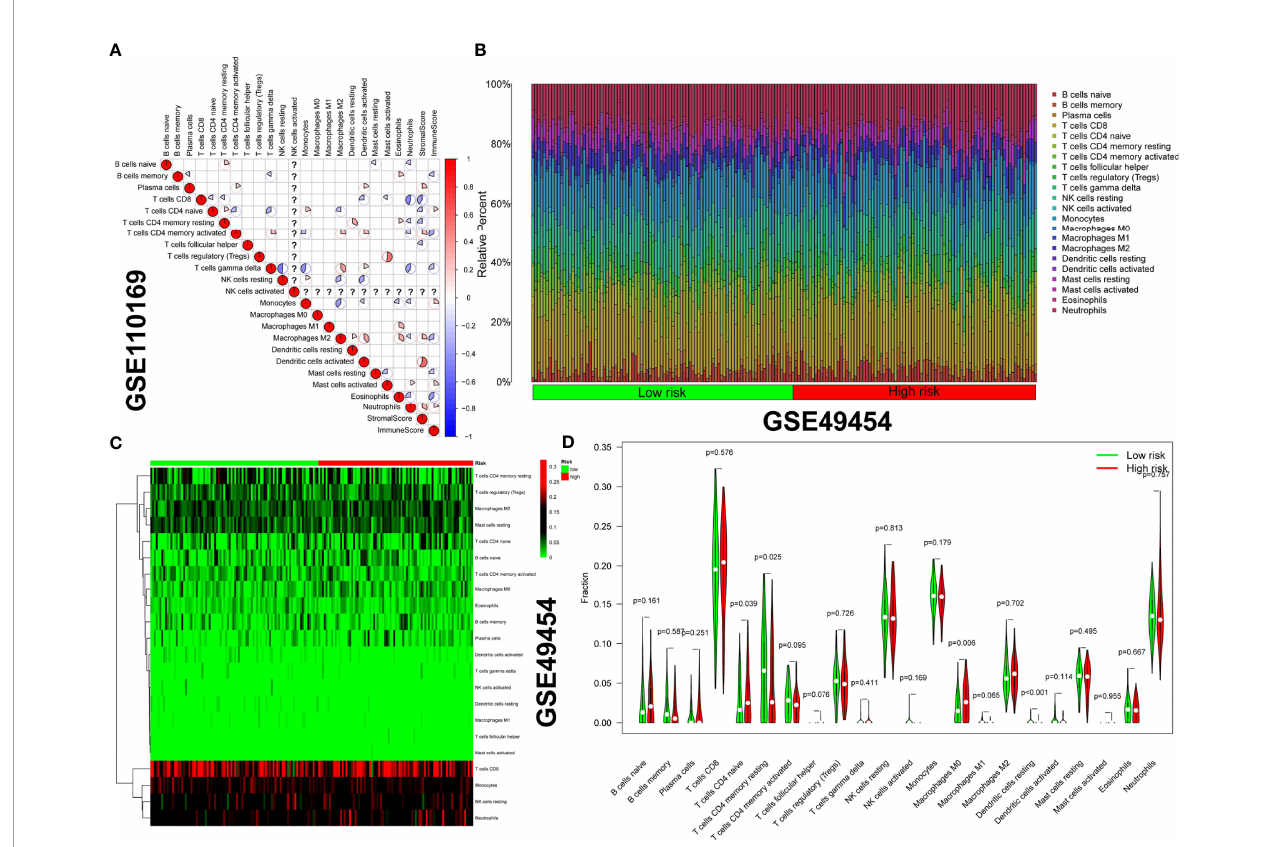
FIGURE 12 | Correlation analysis of immune cells and difference in immune in fi ltration between high- and low-risk patients. (A) A correlation coef fi cient heatmap was generated to visualize the immune cell interaction (the color from red to blue represents positive and negative correlations, and the size of the pie graph represents the absolute correlation coef fi cient). (B) Relative proportions of immune in fi ltration in the high- and low-risk groups. (C) The heatmap illustrates immune in fi ltration in the high- and low-risk groups. (D) Violin plot of immune in fi ltration in the high- and low-risk